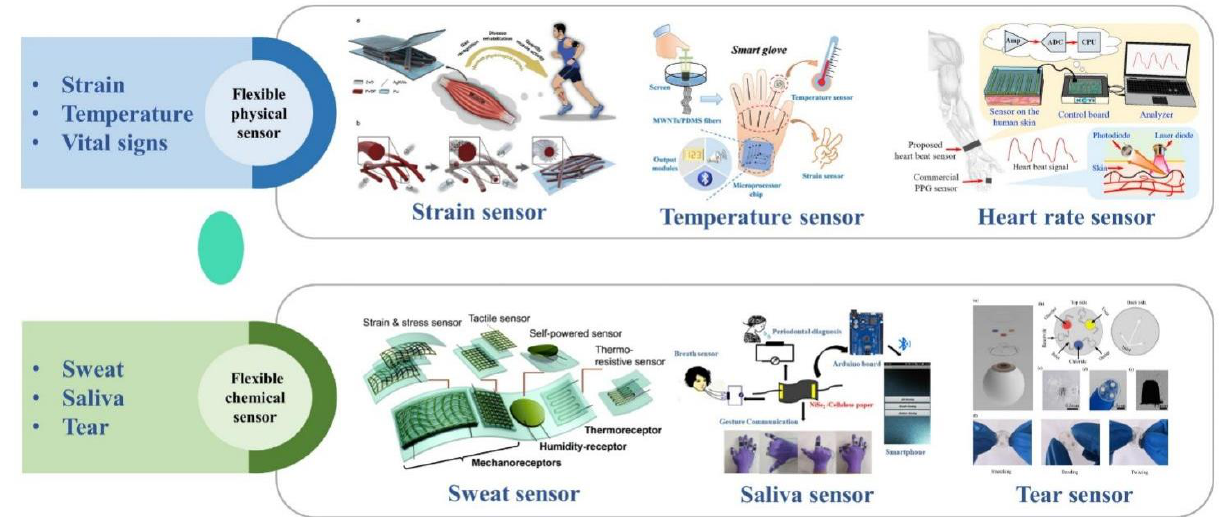
Figure 2. Examples of flexible physical sensors, including strain sensors, reprinted with permission from ref. [15]. Copyright 2020, Elsevier. Temperature sensor, reprinted with permission from ref. [16]. Copyright 2020, American Chemical Society. Heart rate sensor, reprinted with permission from ref. [18]. Copyright 2019, Royal Society of Chemistry. Saliva sensor, reprinted with